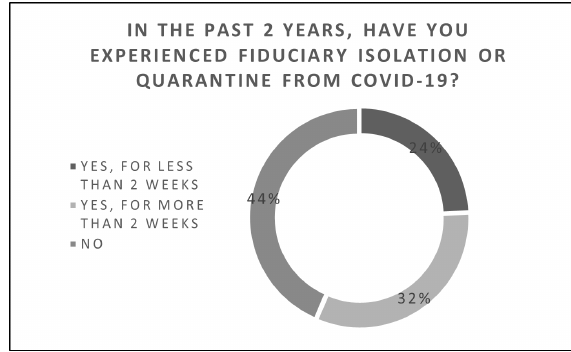
Figure 1: Frequency distribution of age and gender.